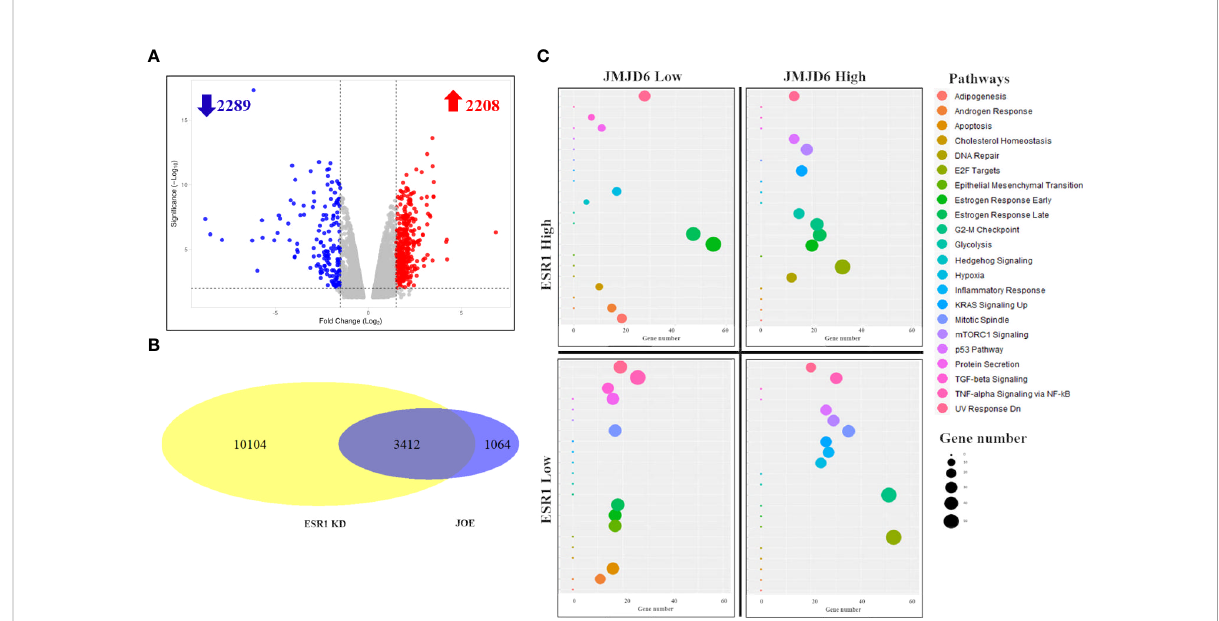
FIGURE 1 RNA-Seq analysis of JOE cells. (A) Volcano plot of differentially expressed genes. Red dots are upregulated genes and blue dots are downregulated genes. (B) Venn Diagram showing the number of overlapping genes between JOE and ESR1 KD cells. (C) Representative fi gure showing enrichment of pathways in 4 subsets of 3412 overlapping genes from the JOE and ESR1 KD sets. 4 quadrants show the enrichment of pathways per subset of genes. Induced by JMJD6 and ESR1 (top right), induced by JMJD6 but suppressed by ESR1 (bottom right); and so on. Each panel depicts a bubble plot with number of genes in each pathway on the X-axis versus the name of the pathway on Y-axis. The pathway and bubble size key are indicated on the